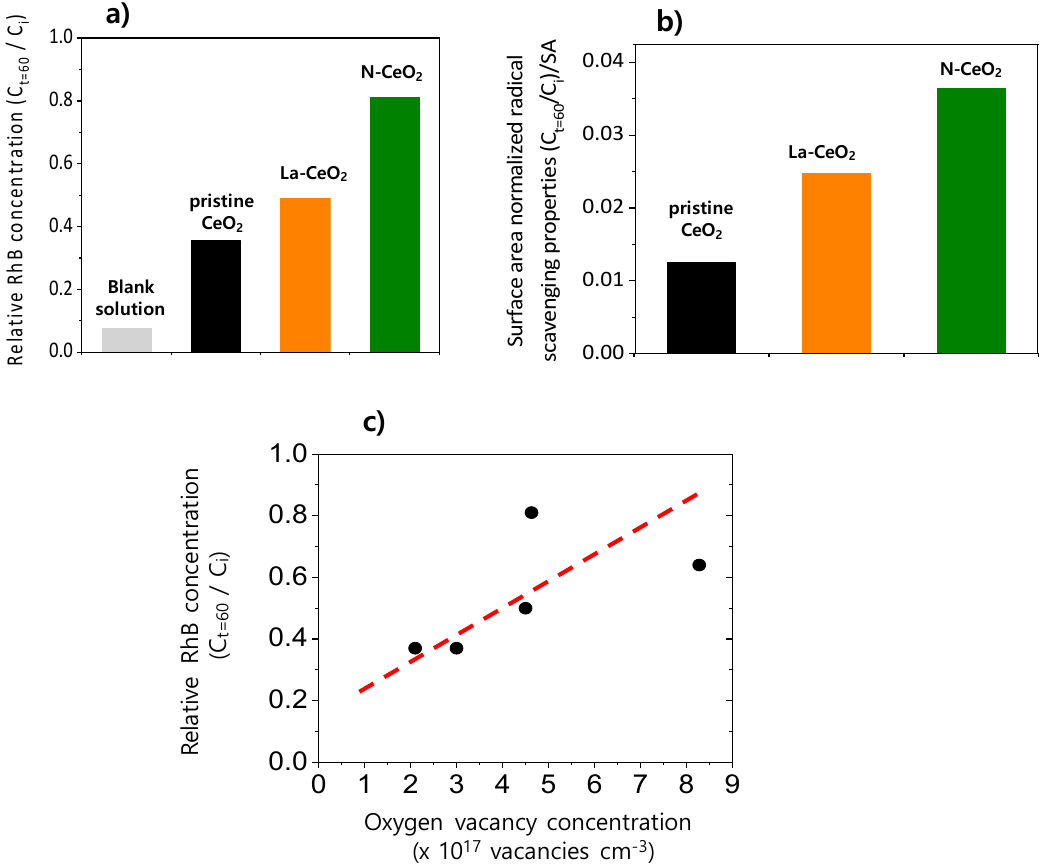
Figure 9. ( a ) Comparison of radical scavenging properties of the pristine CeO 2 , La-doped CeO 2 , and the N-doped CeO 2 NPs. ( b ) Surface area-normalized radical scavenging properties of the samples. ( c ) Correlation of radical scavenging properties of the pristine CeO 2 , La-CeO 2 , and N-CeO 2 NPs with their surface oxygen vacancy concentrations.